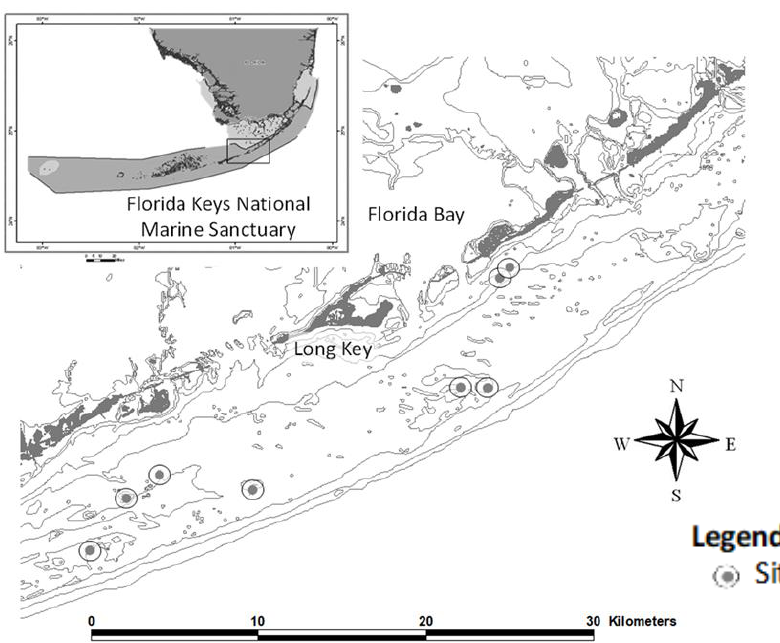
Figure 1. Map to show the location of the eight study sites in the middle of Florida Keys, USA, surveyed during the summers of 2018 and 2019. These eight sites are located inside the Florida Keys National Marine Sanctuary.